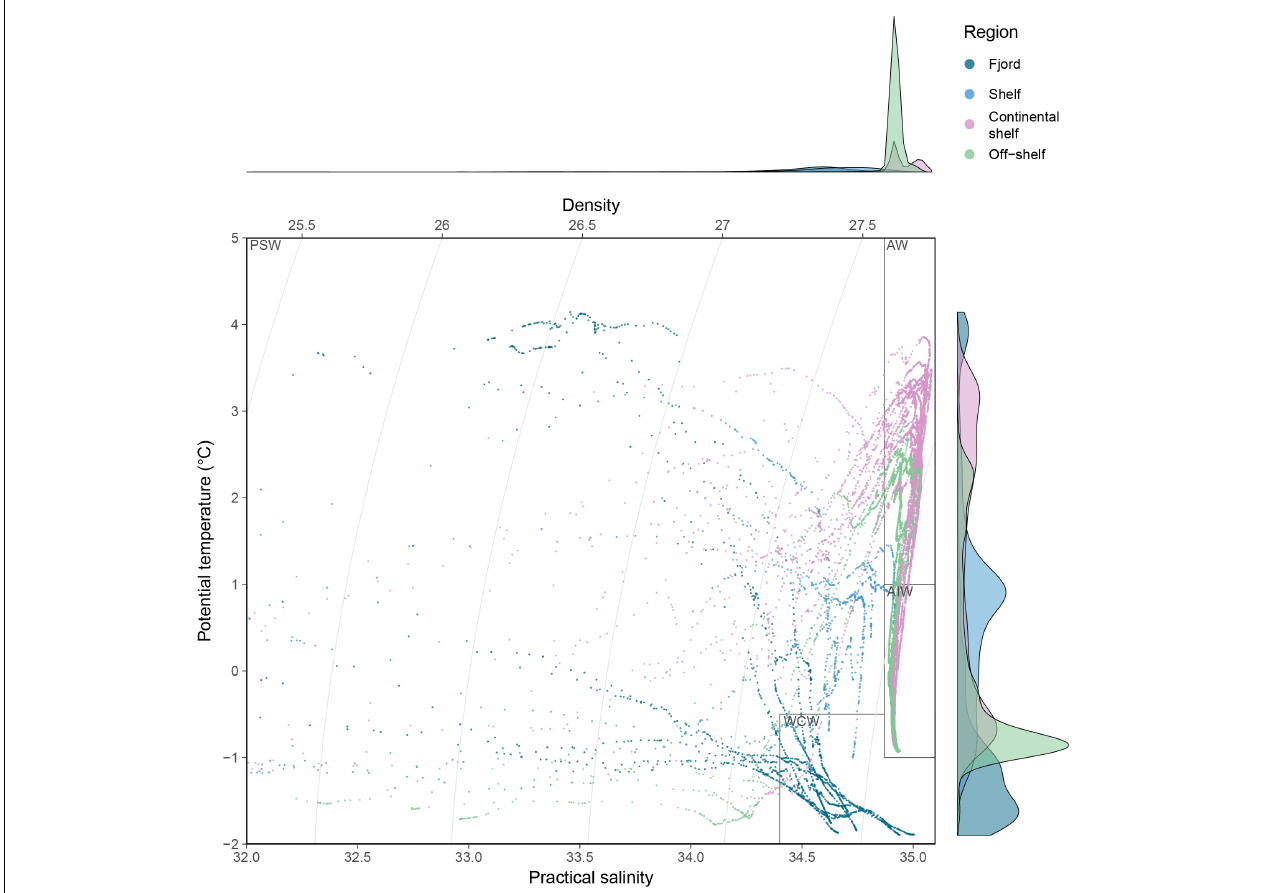
FIGURE 2 | Temperature-salinity plot of all CTD casts in the study. Colors indicate regions and water types are illustrated using polygons (PSW, Polar Surface Water; AW, Atlantic Water; AIW, Arctic Intermediate Water; WCW, Winter Cooled Water). The marginal plots show the density distribution of 1 m binned salinity (x-axis) and temperature (y-axis)